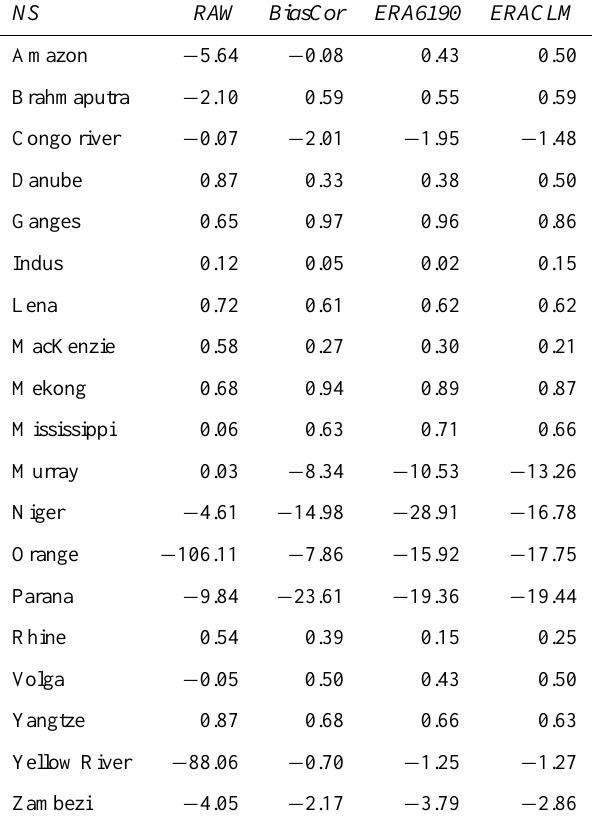
Table 4. Nash-Sutcliffe coefficients for the regimes curves (30-year average monthly mean discharges) of the ERACLM , ERA6190 , ensemble mean non bias-corrected (RAW) and ensemble mean bias-corrected (BiasCor) GCM runs relative to the GRDC